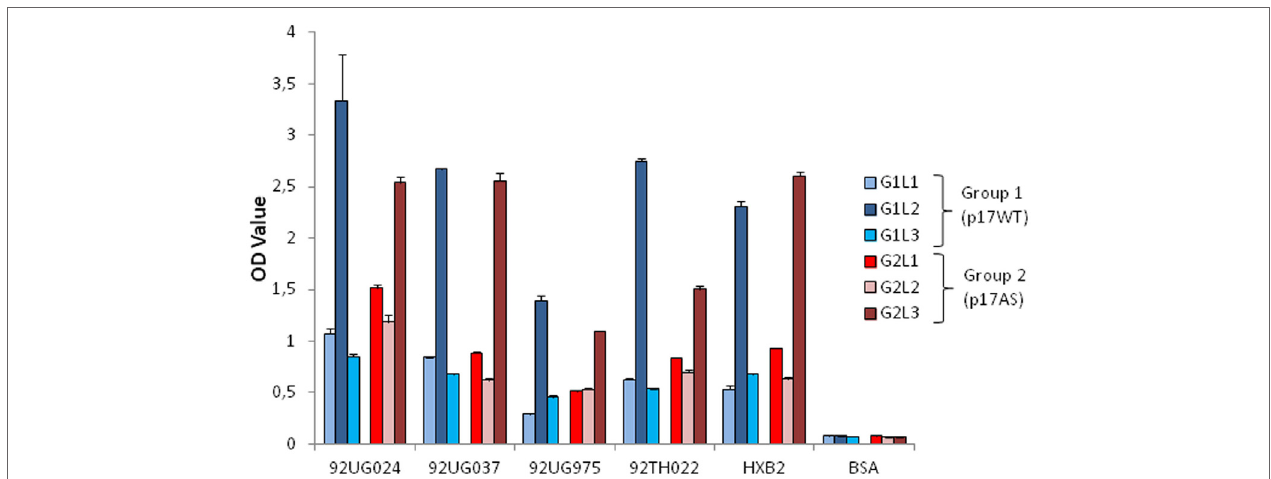
FigUre 4 | Cross-clade reactivity of p17-induced anti-gp41 antibody responses. Recognition of recombinant gp41 fragments from different subtypes by the sera at d98 of each rabbit immunized by p17WT (blue taints) or p17AS (red taints), diluted 1/5,000. Each value represents the mean of the OD value measured individually in duplicate. Error bars represent the SD of the same measures. BSA is the negative protein